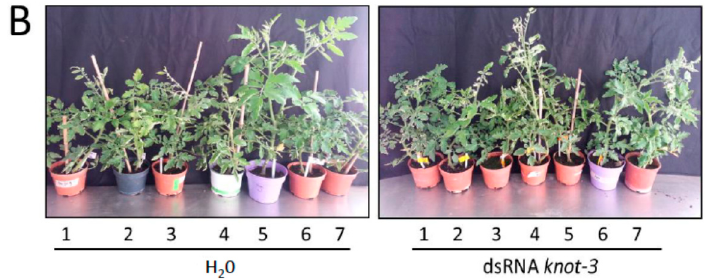
Figure 8. TYLCV amounts and symptoms in tomato plants infected by viruliferous whiteflies without (H 2 O) and with silenced knot ‐ 3. ( A ) TYLCV amounts (viral genomes per plant β ‐ actin genes) in tomato plants 19 days after infection by viruliferous whiteflies without (H 2 O) and with silenced knot ‐ 3 (dsRNA knot ‐ 3 ); ( B ) symptom appearance of tomato plants 24 days after infection with not ‐ silenced (H 2 O) and knot ‐ 3 silenced insects (dsRNA knot ‐ 3 ).